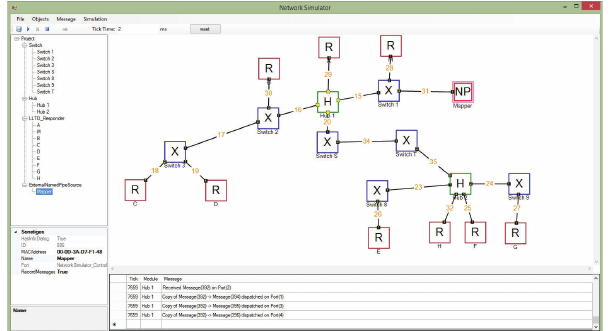
Figure 9: LLTD network simulator with the test topology loaded.